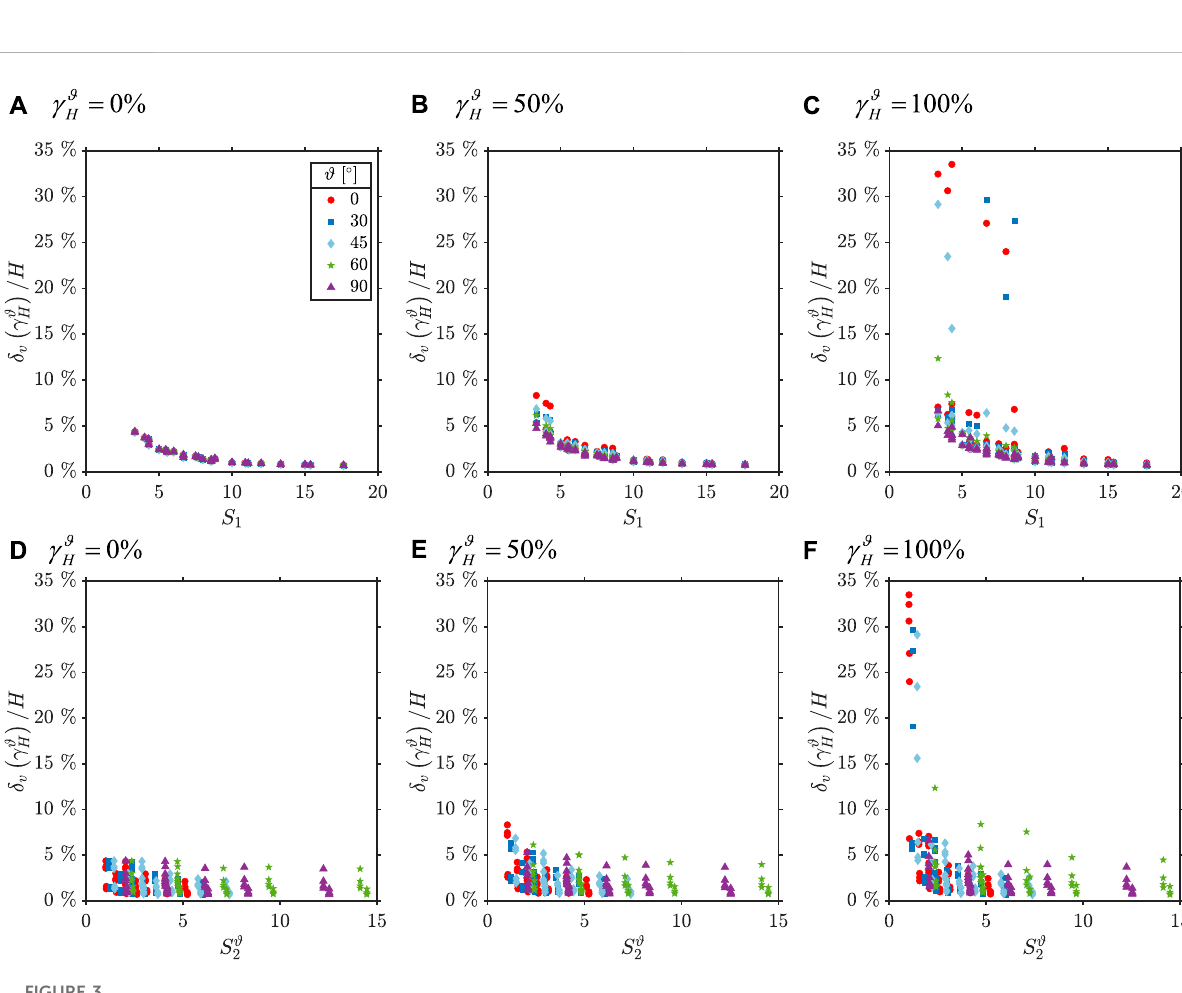
Frontiers in Built